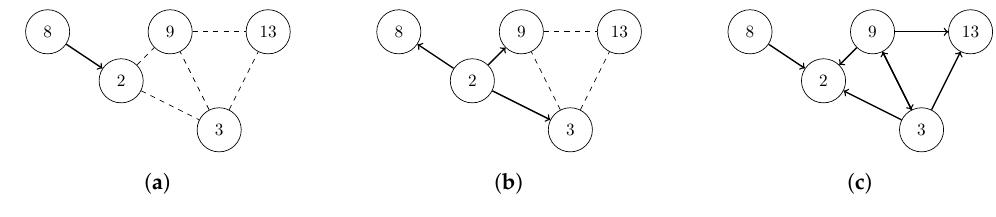
Figure 1. The broadcast storm problem in network flooding. The dashed lines indicate that two nodes are within transmission range of each other. The arrows show a transmission from one node to another one. ( a ) Node 8 broadcasts a packet to node 2. ( b ) Node 2 broadcasts this packet to node 3, 8, and 9. ( c ) Node 8, 9, and 3 broadcast the packet simultaneously to node 2 and others in response.